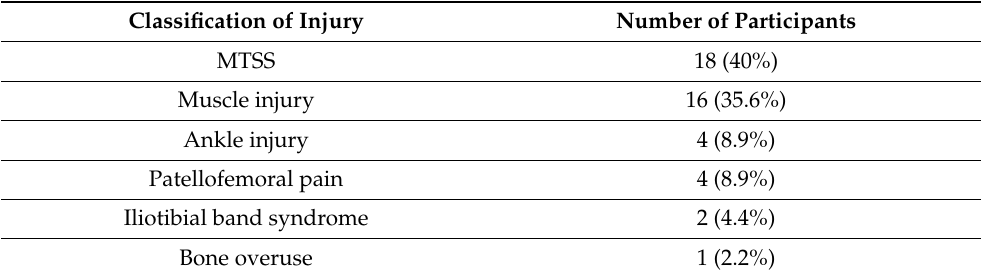
Table 2. Type and incidence of lower limb overuse injury recorded during the follow-up 6